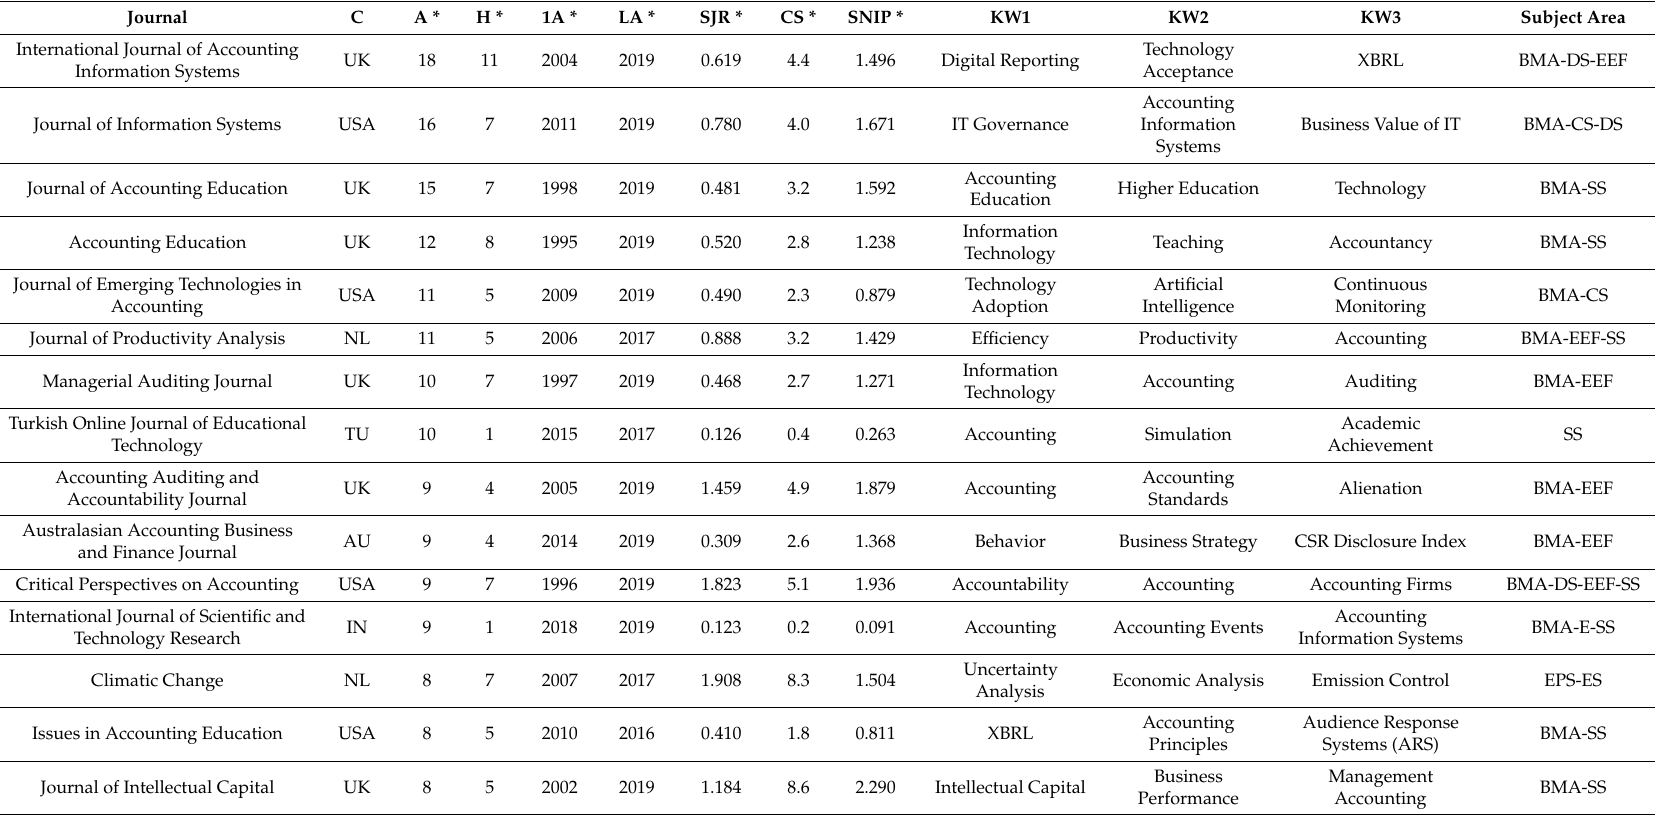
Table 2. Top 15 scientific journals